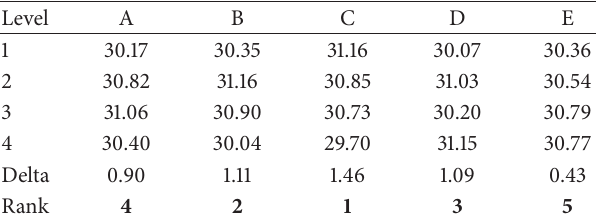
Table 4: Response table for signal-to-noise ratios. Level